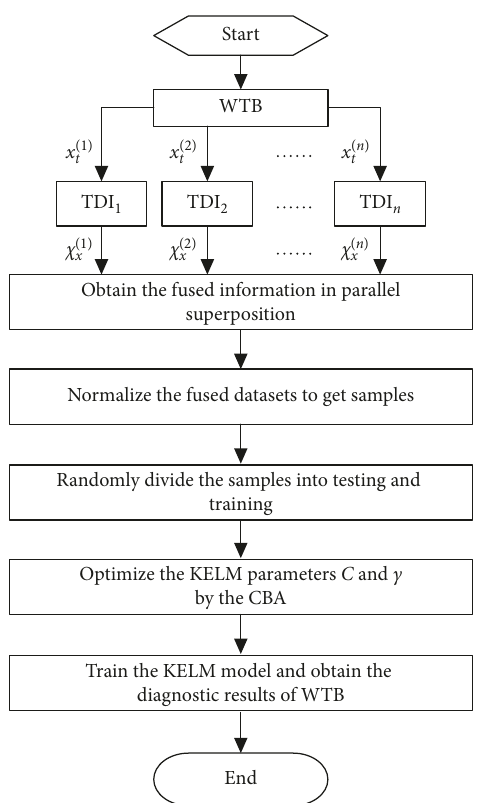
Figure 9: Schematic structure of the proposed CBA-KELM